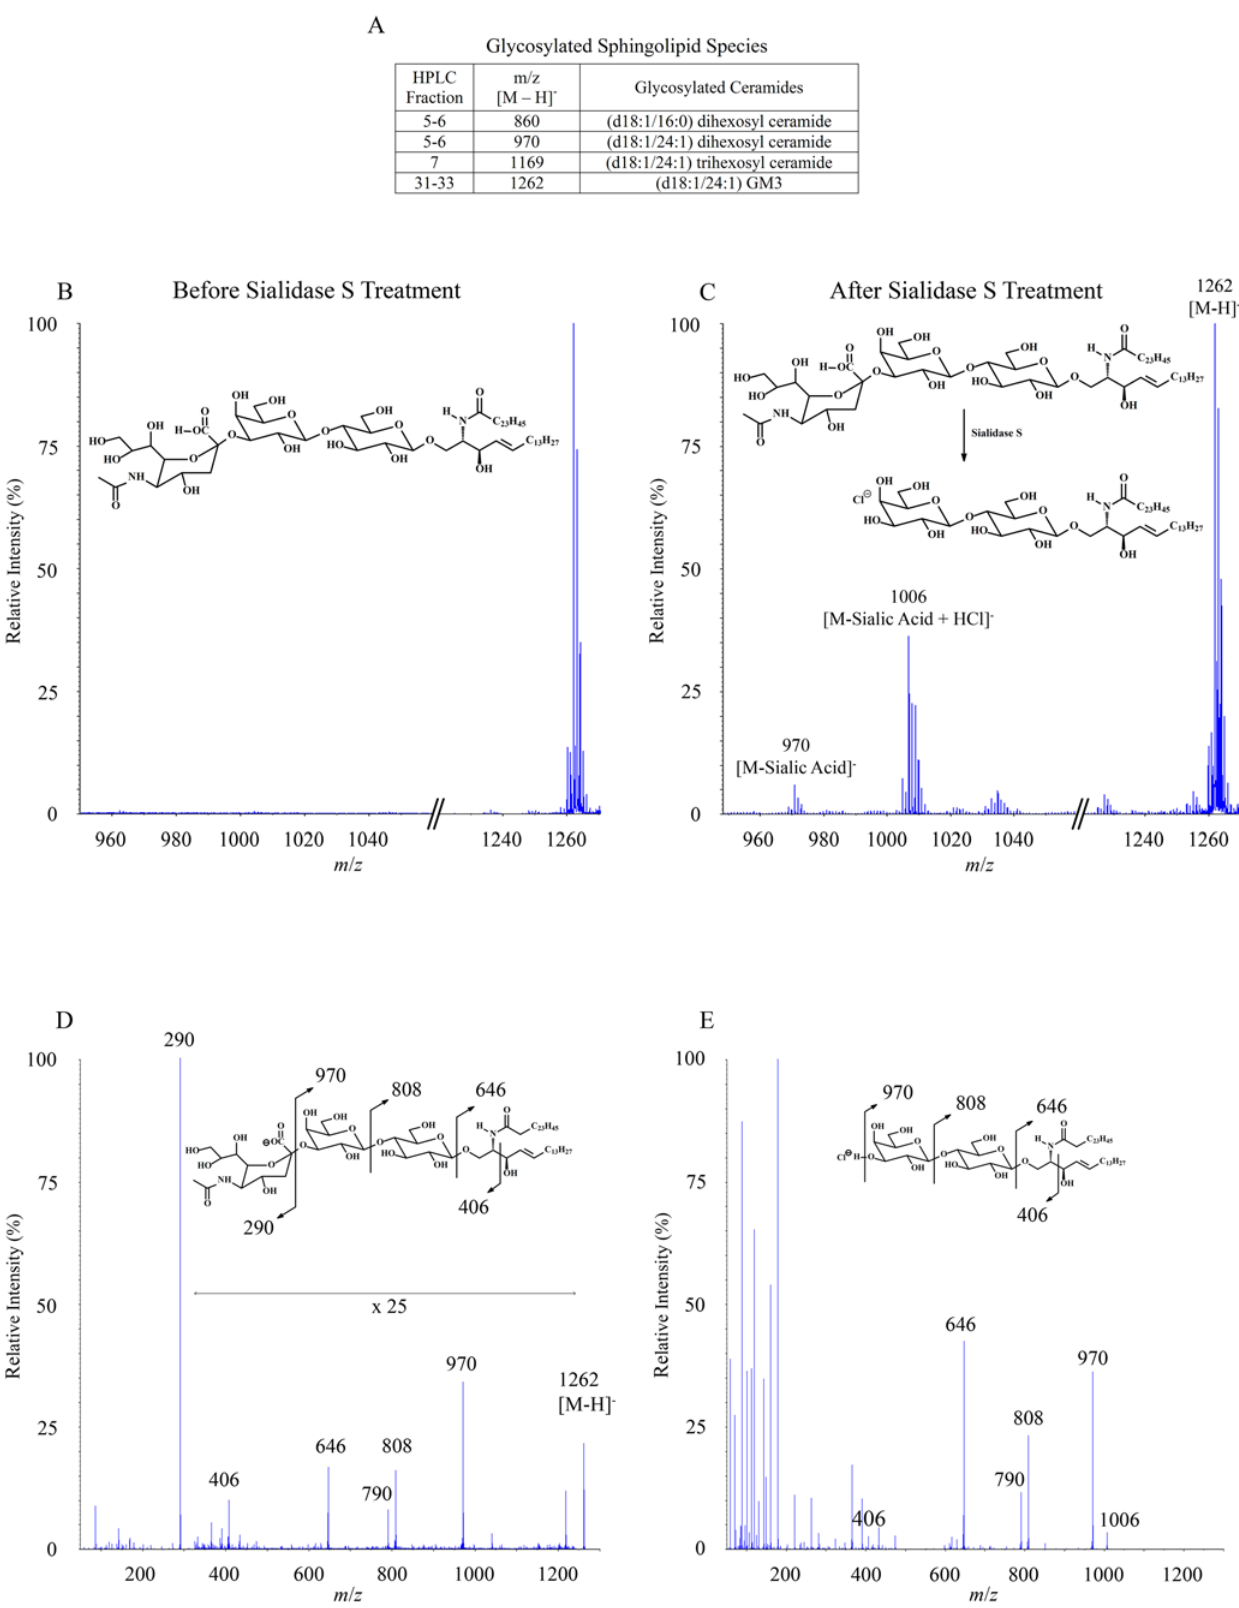
Figure 7. Identification of glycosylated sphingolipids . Four glycosylated sphingolipid species were identified in the CD1d ligand pool. The most abundant species was identified as the ganglioside GM3 (see Figure 1A). Additionally, three glycosylated ceramides were found. A ) Table